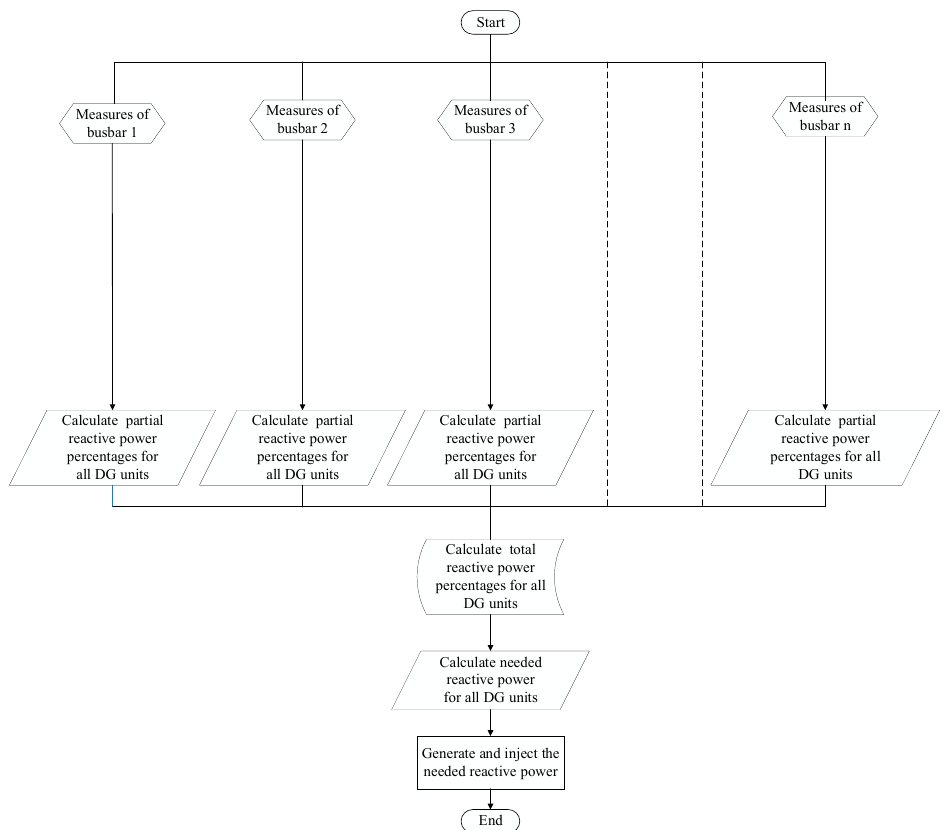
Figure 4. Proposed algorithm for the entire system.